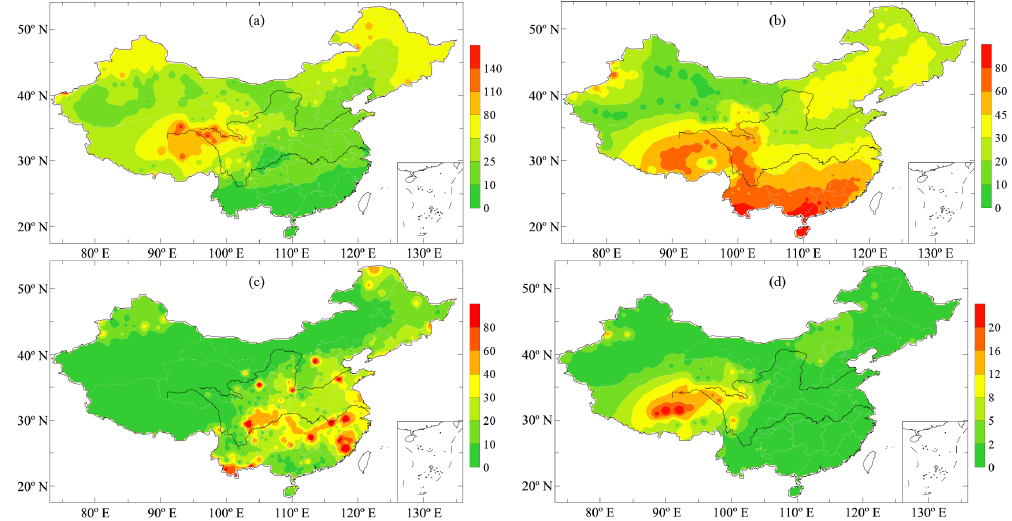
Figure 6. Spatial distribution of annual days of high-impact weather in China during 1959–2014 (unit: daysyr − 1 ; (a) snowfall days, (b) thun- derstorm days, (c) foggy days, (d) hailstorm days).